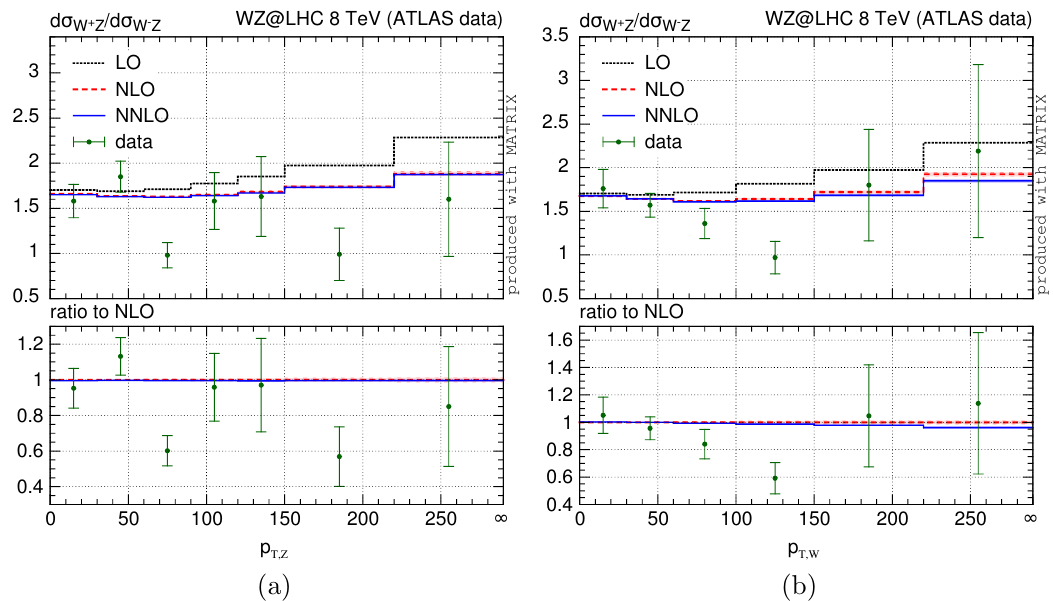
Figure 7 . Same as (cid:12)gure 3, but shows the ratio of cross sections for W + Z and W (cid:0) Z production. NNLO prediction and fully consistent with it within uncertainties. Finally, in the 2-jet bin even the NNLO contribution is e(cid:11)ectively only LO, and our computation cannot provide a reliable prediction. Indeed, it signi(cid:12)cantly overestimates the measured cross section. A more accurate description of the 2-jet bin requires at least NLO QCD corrections to the W (cid:6) Z + 2 jets process